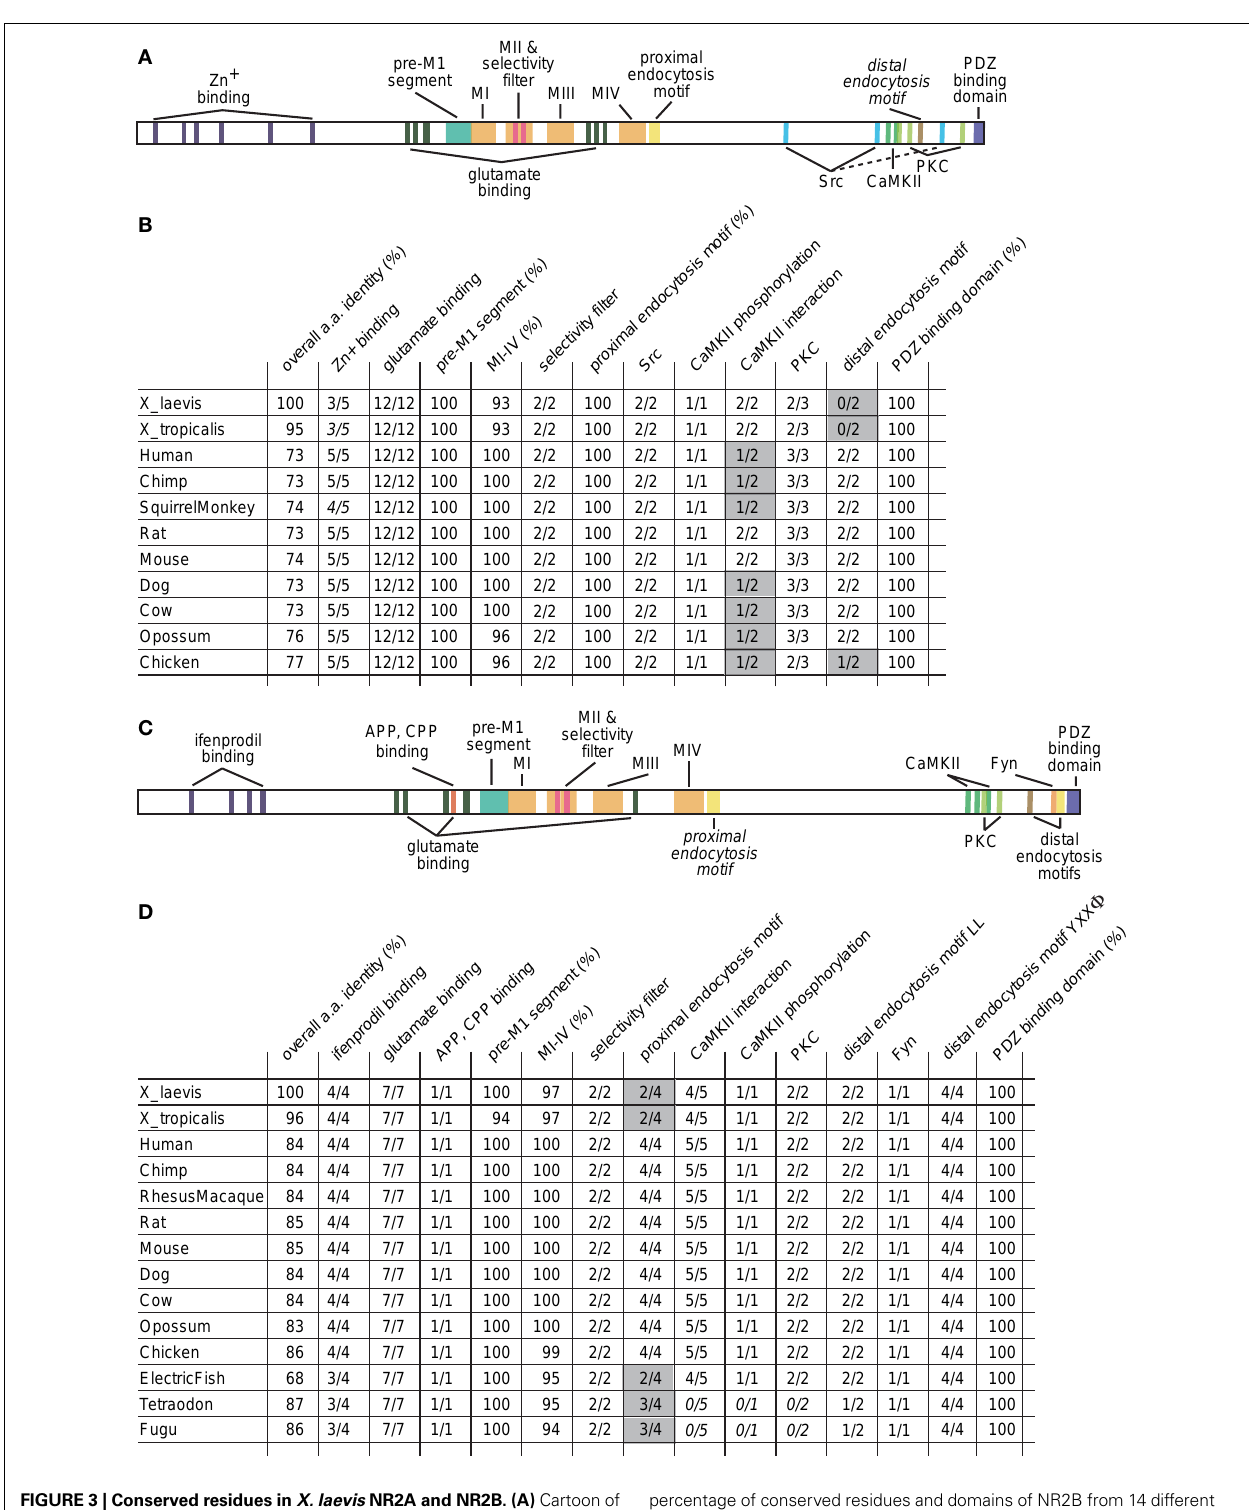
FIGURE 3 | Conserved residues in X. laevis NR2A and NR2B. (A) Cartoon of the annotated functional domains and residues of NR2A. (B) Table of the number and percentage of conserved residues and domains of NR2A from 11 different species. The overall amino acid identity was determined in comparison to the X. laevis NR2A protein. (C) Cartoon of the annotated functional domains and residues of NR2B. (D) Table of the number and